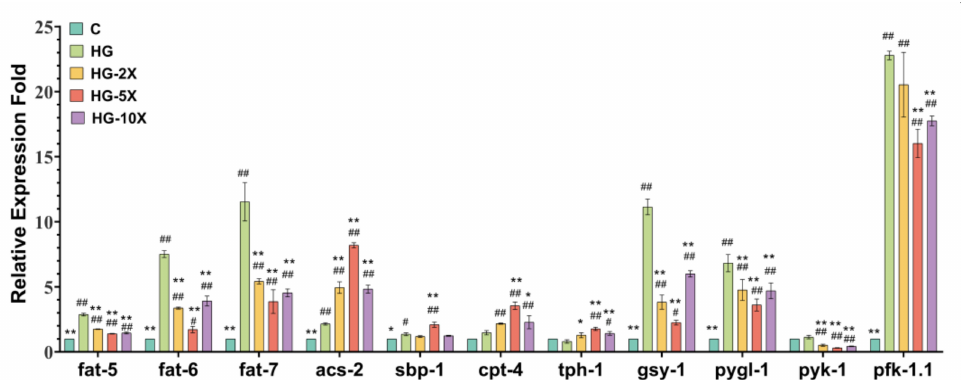
Figure 5. Supplementation with A. muciniphila cell-free supernatant on glycolipid metabolism gene expression of C. elegans . The results are expressed as mean ± SD deviation, and p -values are calculated by Tukey’s test. Compared with the control group, # and ## are significantly different at p < 0.05 and p < 0.01, respectively; compared with the high-glucose group, * and ** are significantly different at p < 0.05 and p < 0.01,